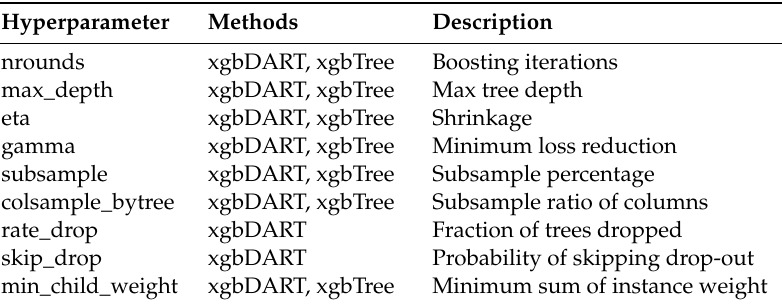
Table 3. Gradient boosting